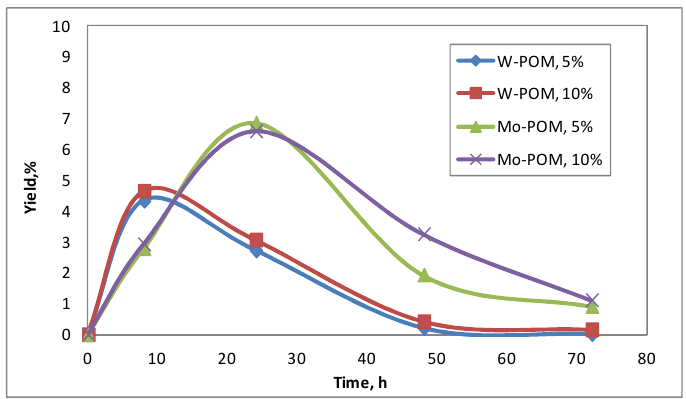
Figure 4. Conversion of cellulose to HMF in [BMIM]Cl at 120 °C by using tungsten and molybdenum oxide-based POMs at 5 and 10% substrate loading. Catalyst loading was 10 wt % from cellulose and cellulose loading was 5 or 10 wt % from solvent.